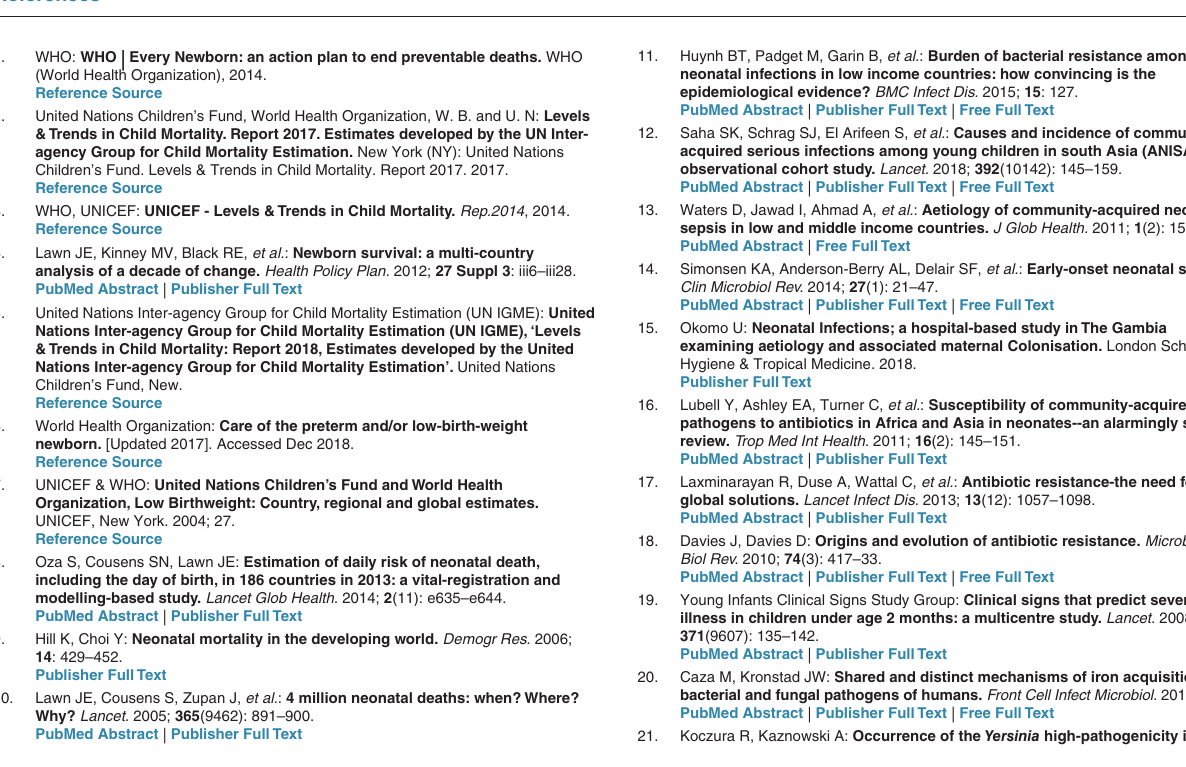
Figshare: Cross et al. Gates Open Research SCC1525v2__NeoIn- nate_Consent form Route 2_Part 2_(Post-Delivery) - ANC Outside SGH v1-Approved 8Nov17. https://doi.org/10.6084/ m9.figshare.8069243.v1